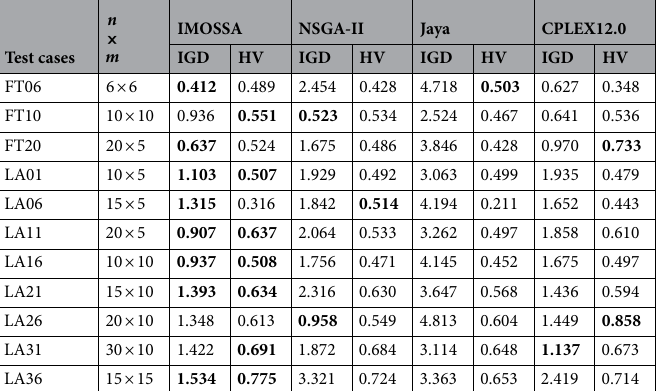
IGD HV Sum of squares